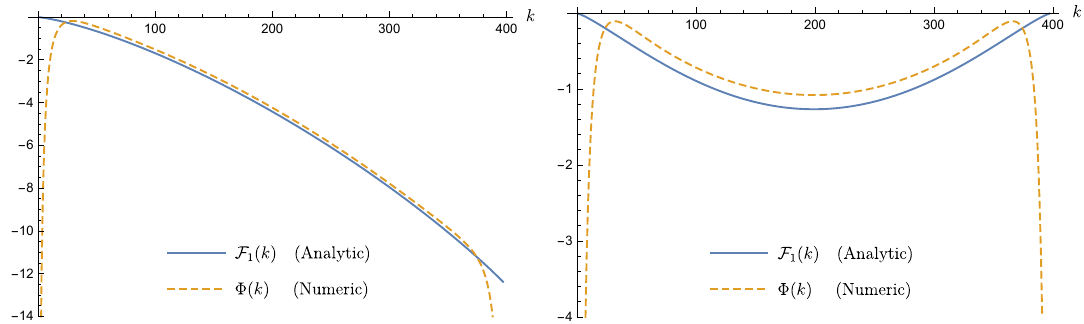
Figure 3 . Numerical versus analytic results for as a function of k . This was defined via F 1 equations (2.8), (2.11), (2.20). The solid blue line is our analytic result for , and its numerical F 1 approximation Φ( k ) (defined in (4.4)) is given by the orange dashed line. The plot on the left is for gauge group U( N ) (eq. (3.52)) while that on the right is for SU( N ) (eq. (3.55)). (As in figure 1, we N have replaced d A = 1 k → (cid:0) (cid:1)